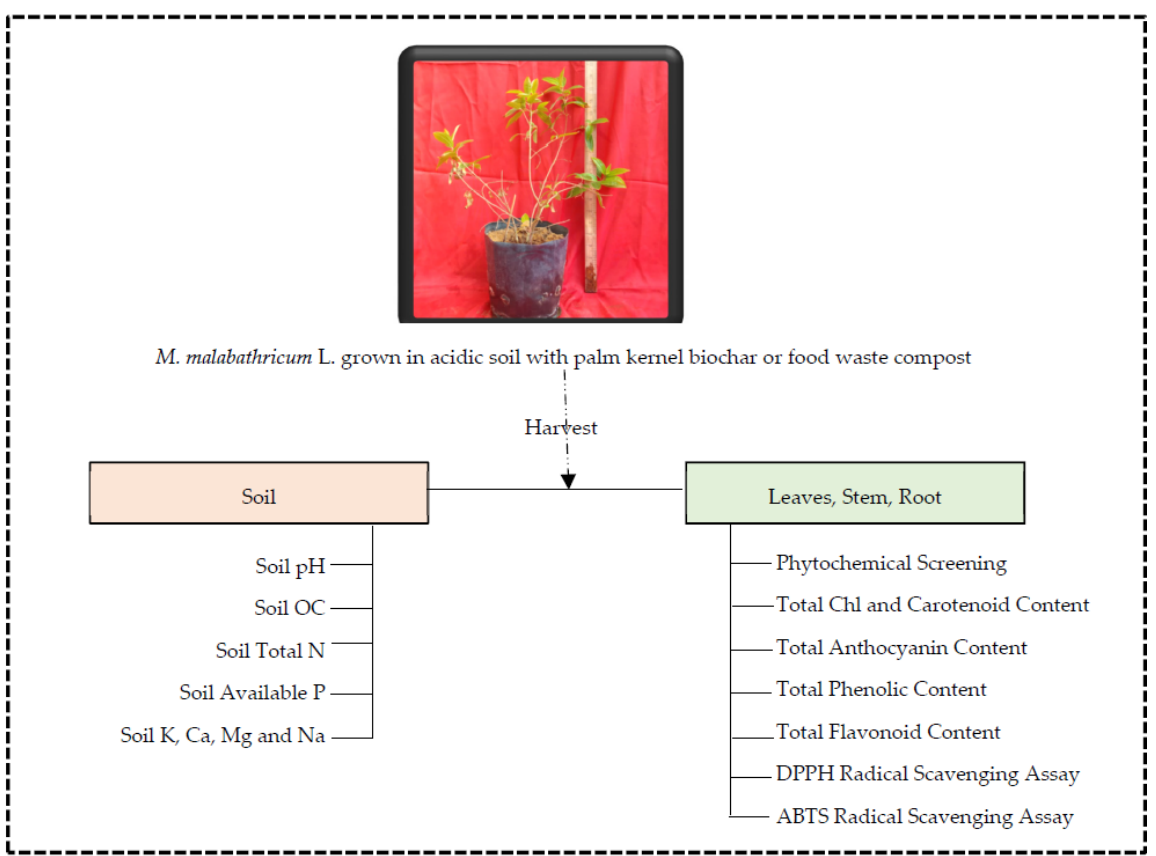
Figure 3. A schematic flow chart of methodology used in this study.